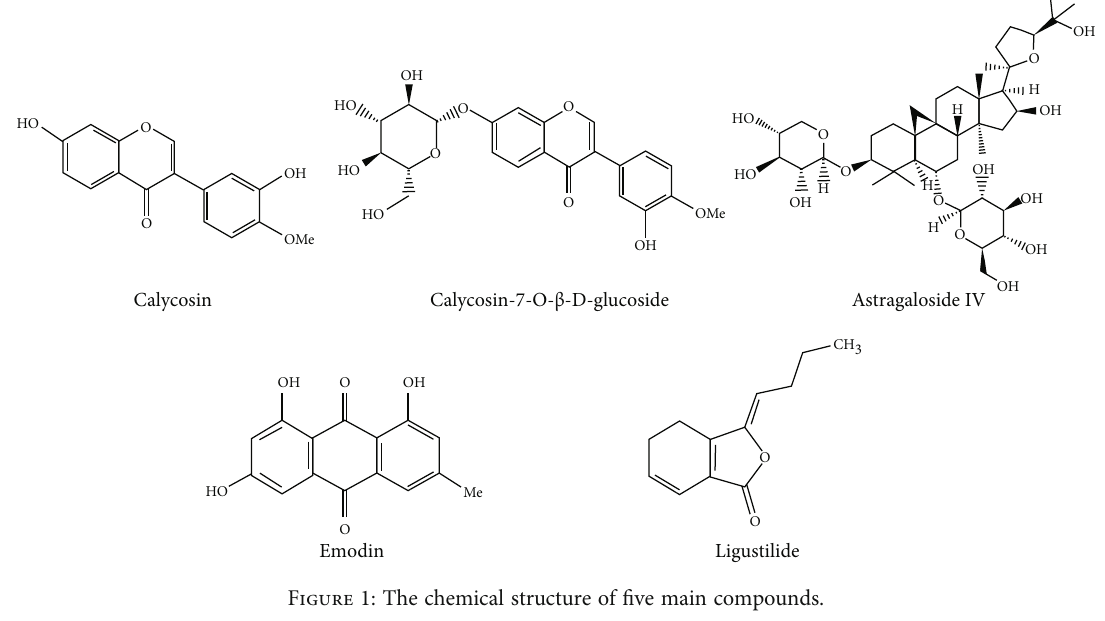
Figure 1: The chemical structure of fi ve main compounds.